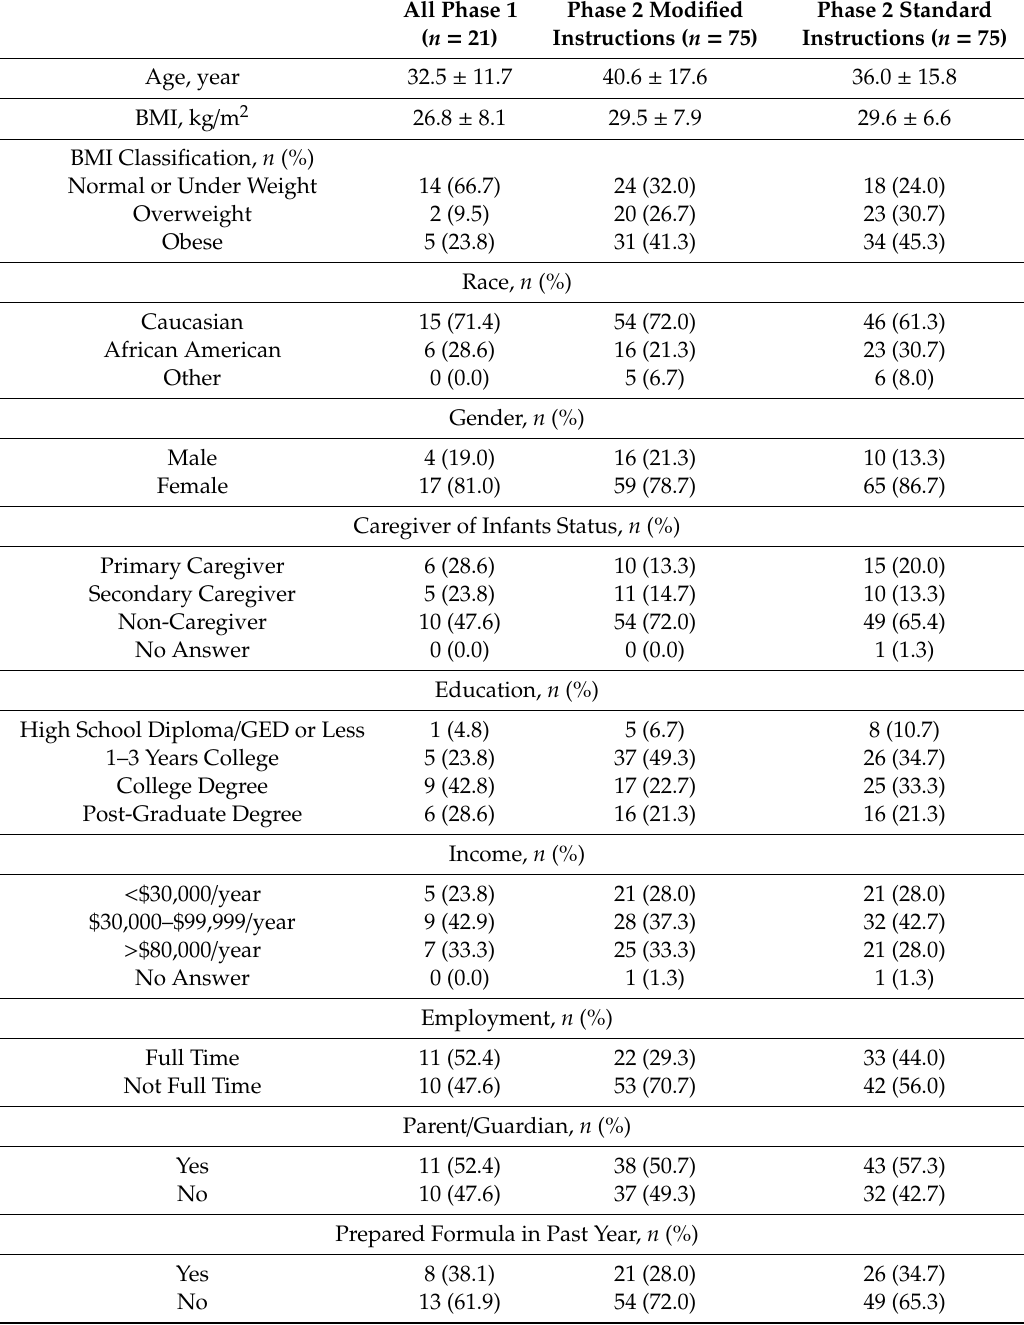
Table 1. Characteristics of Study